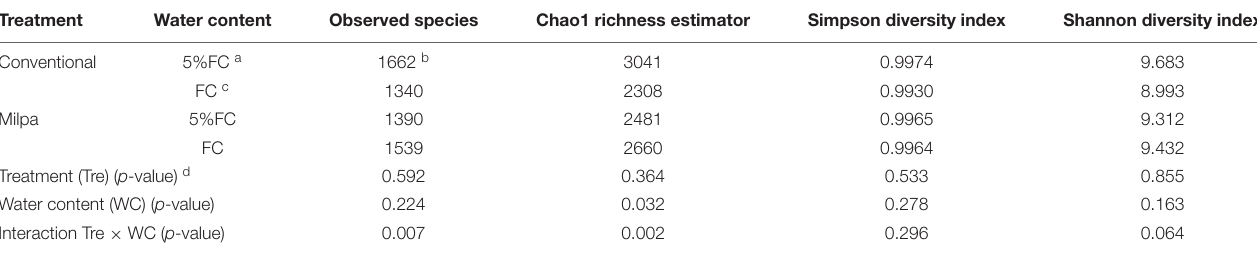
TABLE 5 | Non-parametric analysis of the effect of soil cultivation technique and soil moisture content and their interaction on the alpha diversity of the bacterial populations in soil cultivated conventionally, i.e., conventional tillage, crop residues removal, chemical fertilizer and herbicide application and monoculture of maize ( Zea mays L.), or an organic milpa system, i.e., zero tillage, retention of crop residues, organic fertilizer application, weed management and crop rotation of maize, pumpkin ( Cucurbita sp.) and beans ( Phaseolus vulgaris L.), for 3